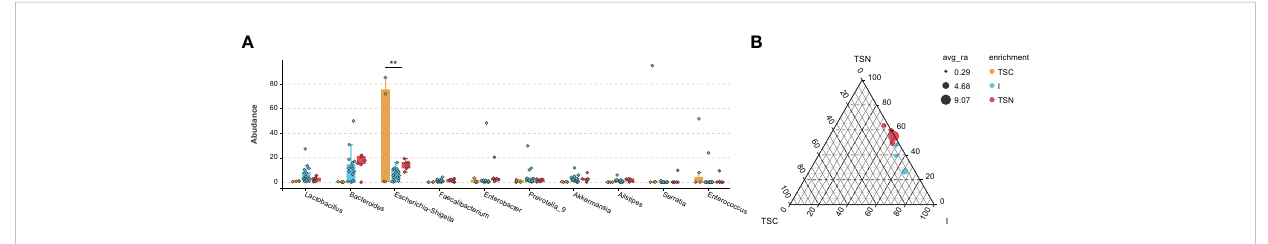
FIGURE 4 The Effect Analyses of Swabbing Exposure. The characteristic taxa were measured by indicator analysis (A) and ternary plot (B) . The P values were conducted by Tukey HSD test. Statistical signi fi cance is displayed as *P < 0.05 and **P < 0.01. TSC, Transitional stools of caesarean delivered neonates; I, Transitional stools of caesarean delivered neonates with the treatment of swabbing maternal vaginal fl uid intervention; TSN, Transitional stools of natural delivered neonates; VN, Vaginal fl uids of the pregnant women who underwent natural delivery; V, Vaginal fl uids of the pregnant women who underwent caesarean delivery; FN, Feces of the women who underwent natural delivery; F, Feces of the pregnant women who underwent caesarean